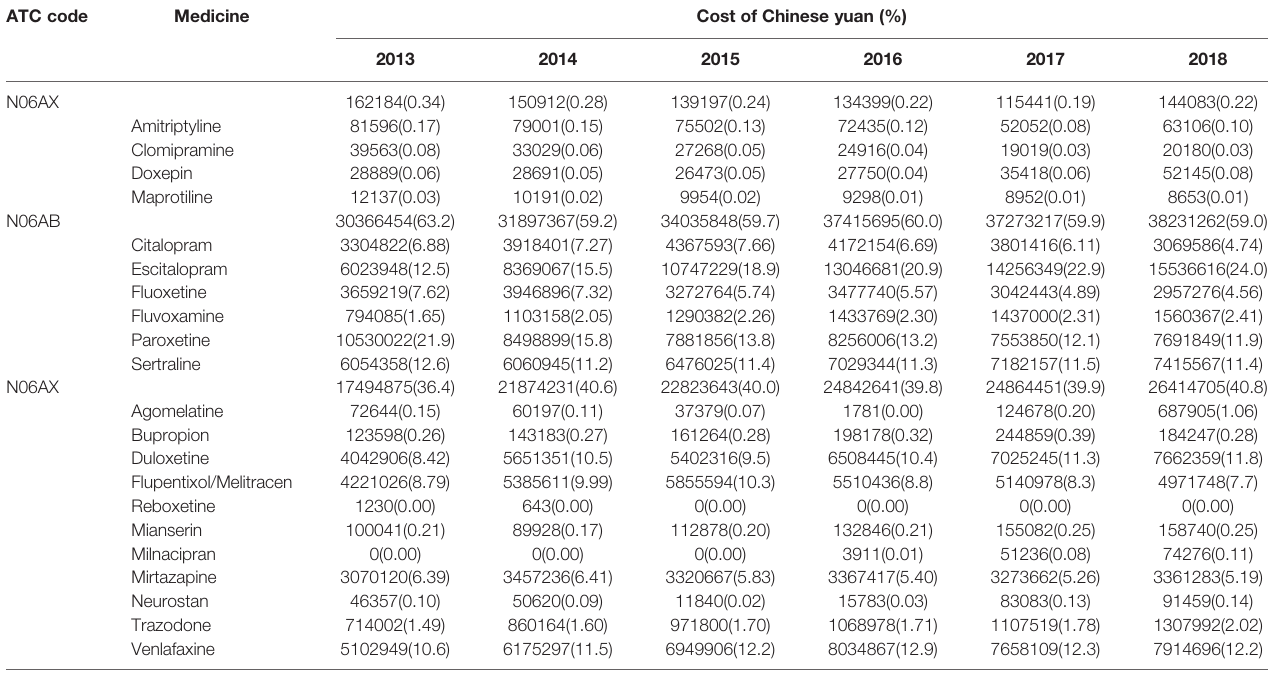
TABLE 3 | Total expenditure on antidepressant medications dispensed from 2013 to 2018 by drug and drug class. ATC code